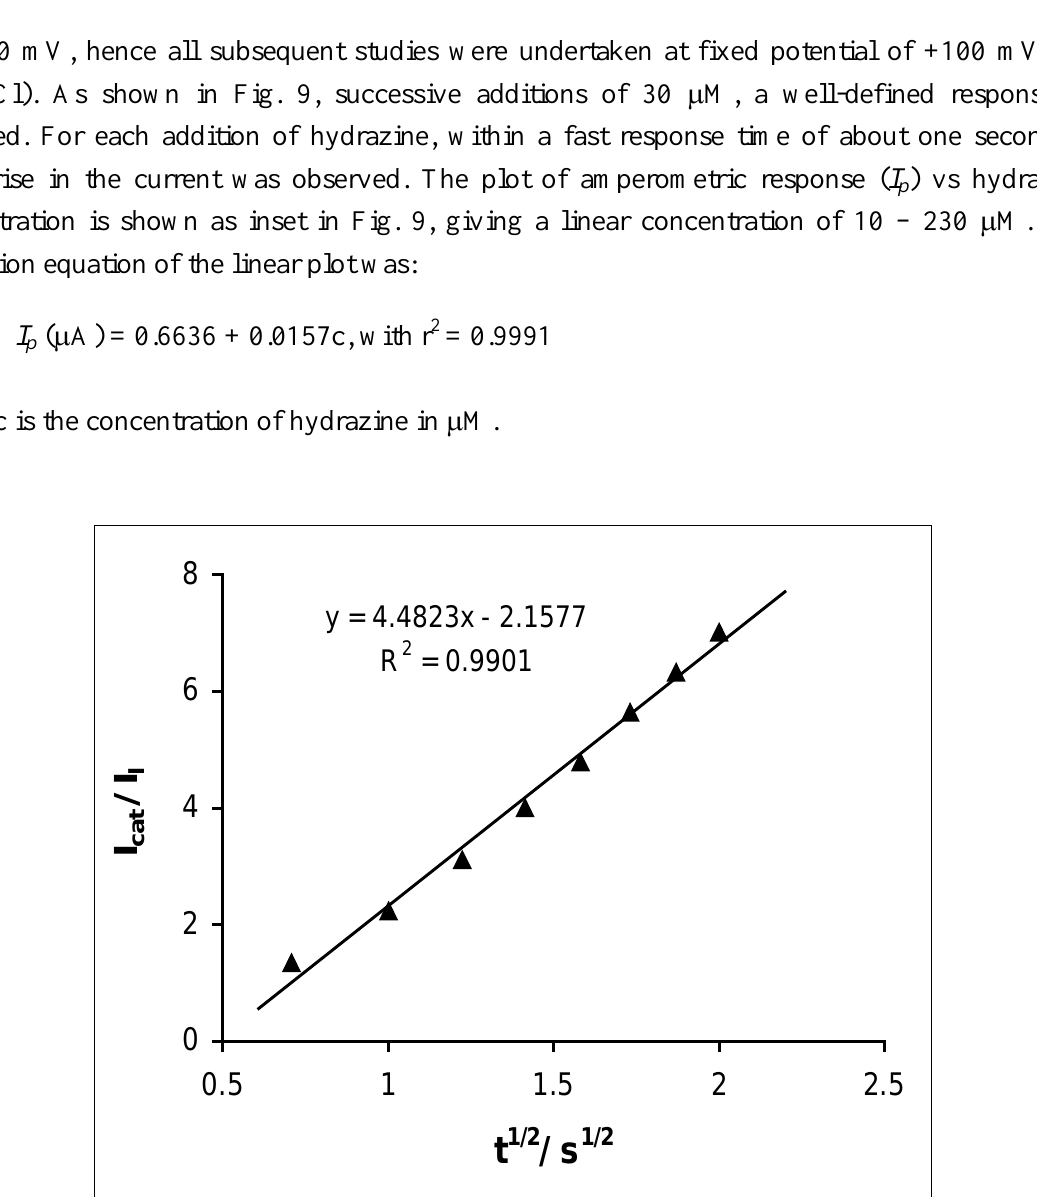
Figure 8: Plot of plot of the I At signal-to-noise ratio of 3, the detection limits were obtained as approximately 1.0 µ M. To